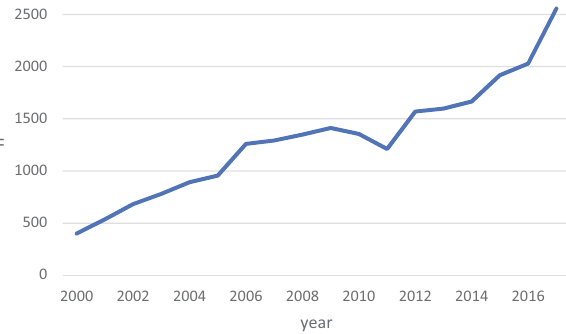
Figure 3: Number of agritourism boarding houses in Romania over the period of study ( source: author ’ s elaboration on data available at http://statistici.insse.ro:8077/tempo -